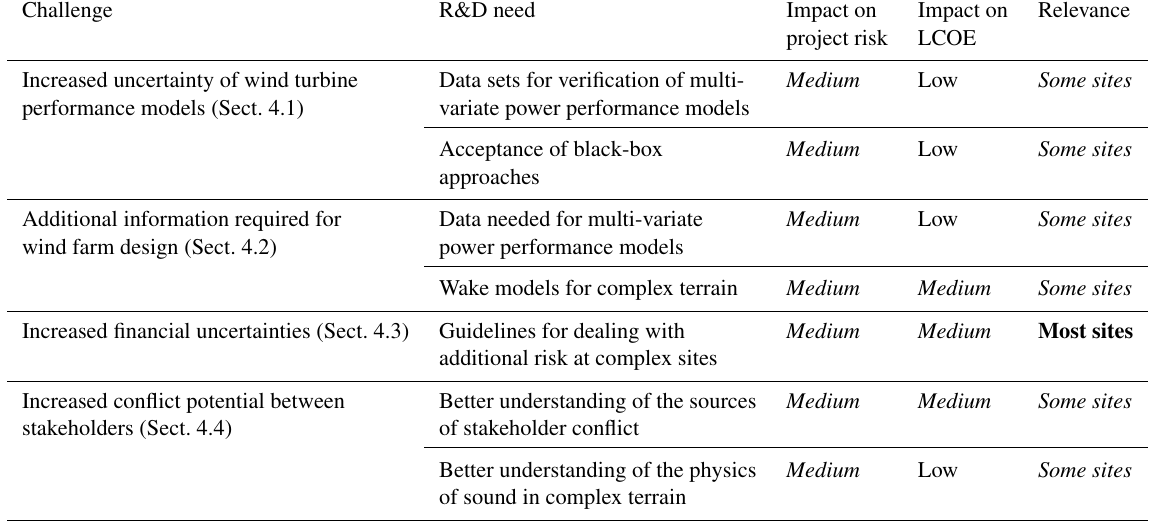
Table 3. Challenges and R&D needs for project planning in complex locations. The table follows the format of Table 1. Challenge R&D need Impact on Impact on project risk LCOE Increased uncertainty of wind turbine Data sets for verification of multi- Medium Low Some sites performance models (Sect. 4.1) variate power performance models Acceptance of black-box approaches Data needed for